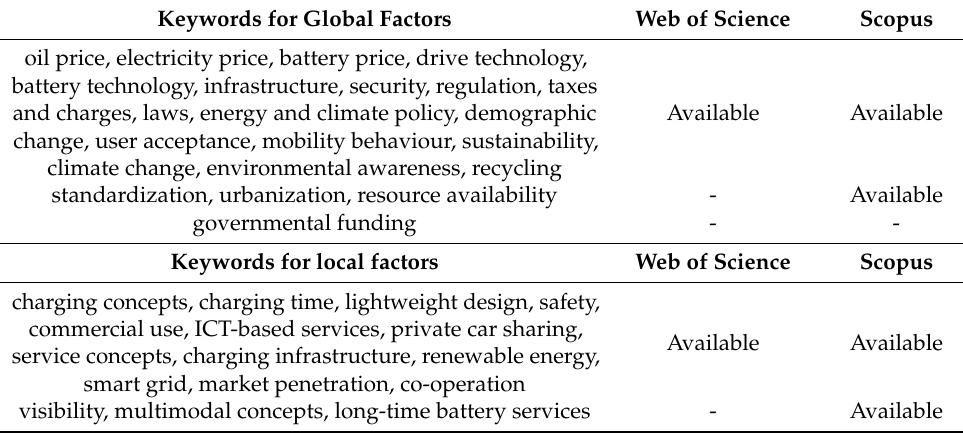
Table 5. Availability of search queries in Web of Science and Scopus